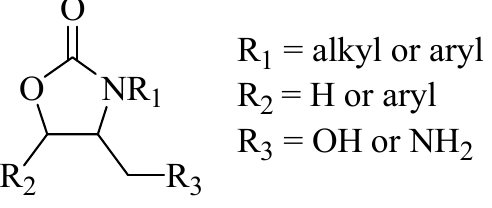
Figure 1. Antimicrobial oxazolidin-2-ones.